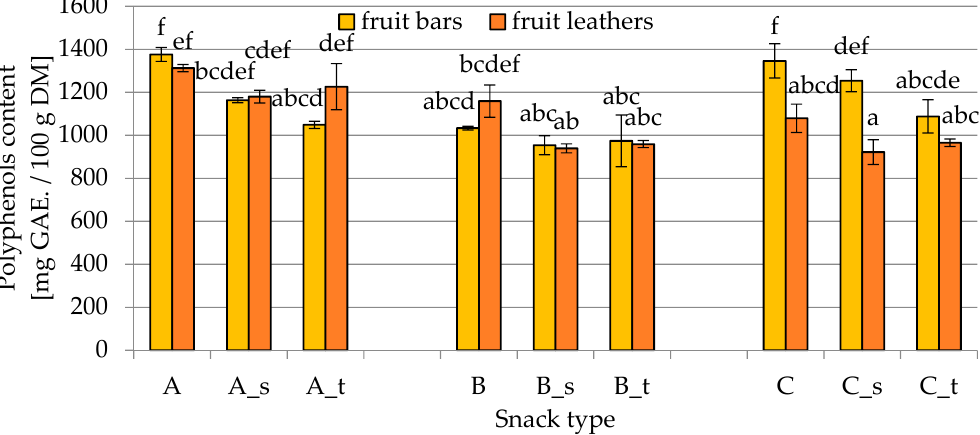
Figure 2. Polyphenols content in fruit bars and leathers (A, B, C—different composition; s—sucrose addition; t—trehalose addition) determined by the Folin–Ciocalteu method, as described in Section 4.2.2. Different letters above the columns indicate significant differences ( α = 0.05) between all considered samples.